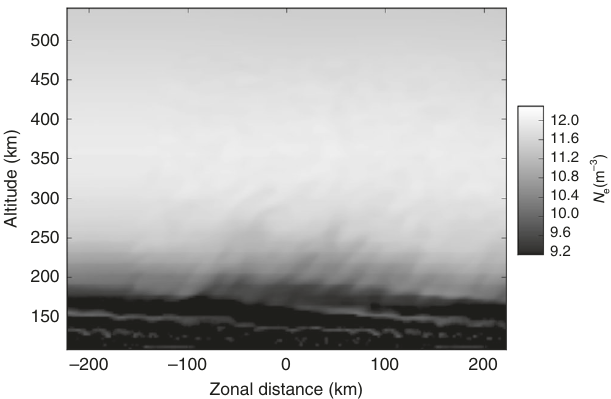
Fig. 6 Detailed view of a vertical cut through the simulated electron density after 25 min of simulation time in